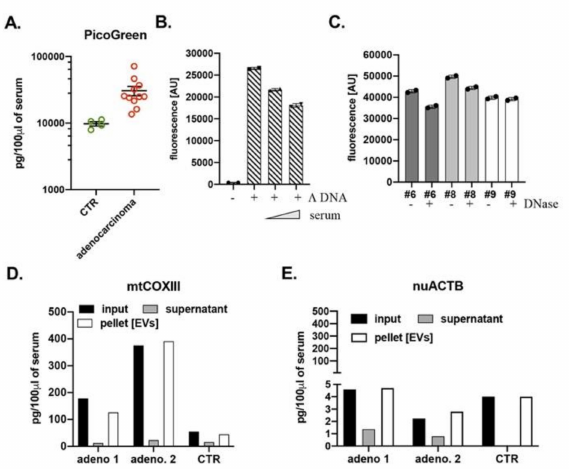
Figure 3. Circulating extracellular vesicles (EVs) contain a majority of the ccf-DNA that has mito- chondrial origin. ( A ) PicoGreen quantification of ccf-DNA in serum of healthy volunteers ( n = 4) and subjects with lung adenocarcinoma ( n = 12) admitted to UTMB’s clinic. ( B ) Serum contain active DNase/s. Changes in the fluorescent units of Λ DNA incubated with increasing volume of serum (40 and 80 µ L). ( C ) Ccf-DNA is DNase insensitive. Serum samples of three lung adenocarcinoma subjects were incubated with recombinant DNase and changes in DNA concentration measured with PicoGreen™ expressed in fluorescent units are shown. Ccf-DNA is localized within lumen of EVs. Comparison in the amount of DNA between input, serum after EVs isolation (supernatant) and isolated EVs (pellet) of three subjects using ( D ) mtCOXIII and ( E ) nuACTB